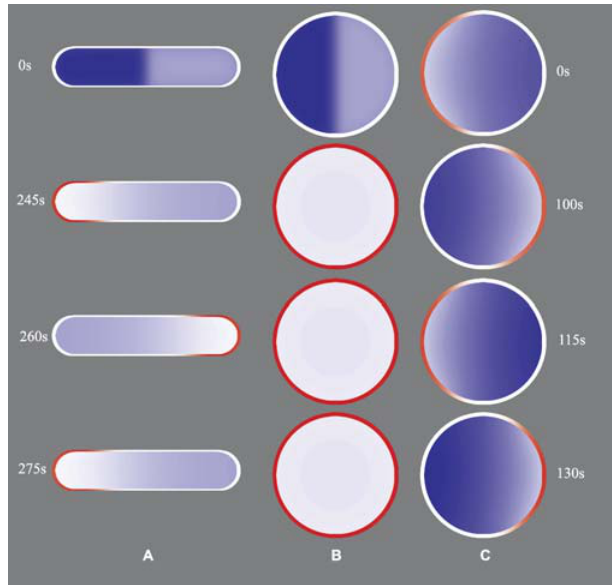
Figure 6. Comparison of Mean-Field Results for wt and Two Spherical Cells with Different Initial Conditions Membrane-bound MinD is shown in red, and cytosolic MinD ATP is shown in blue. The color intensity is proportional to the integrated concen- tration of molecules along the axis perpendicular to the projection plane. In (A) (wt) and (B) (spherical), the series are initialized with 3/4 of the MinD in the cytoplasm in one half of the cell and 1/4 in the other half. In (C) (spherical), the series is initialized with most of the MinD membrane bound at one side of the cell. DOI: 10.1371/journal.pcbi.0020080.g006